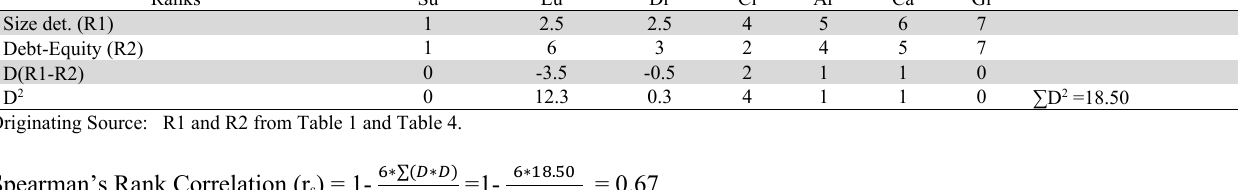
Table 8 Rank correlation between averages of size determinants ranks and Debt- equity ratio Ranks